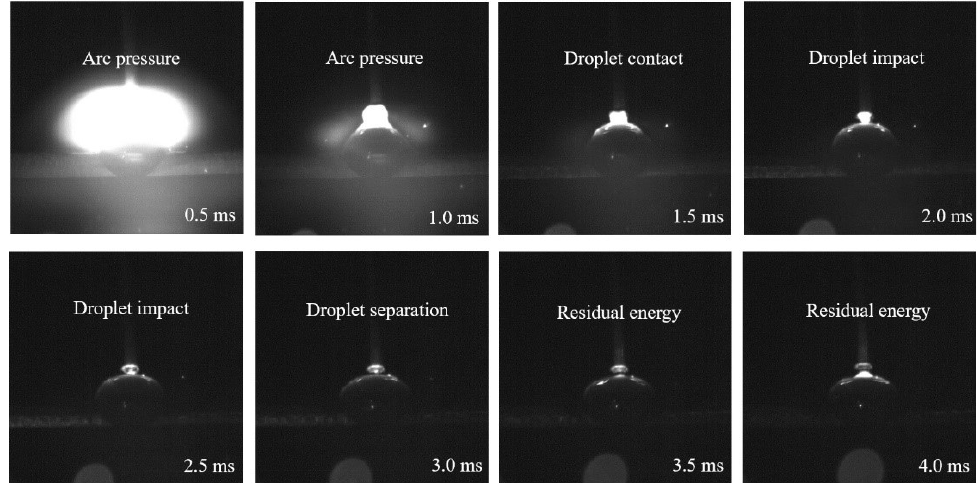
Figure 12. Controlled driving cycle of the molten pool with a welding current of 100 A.